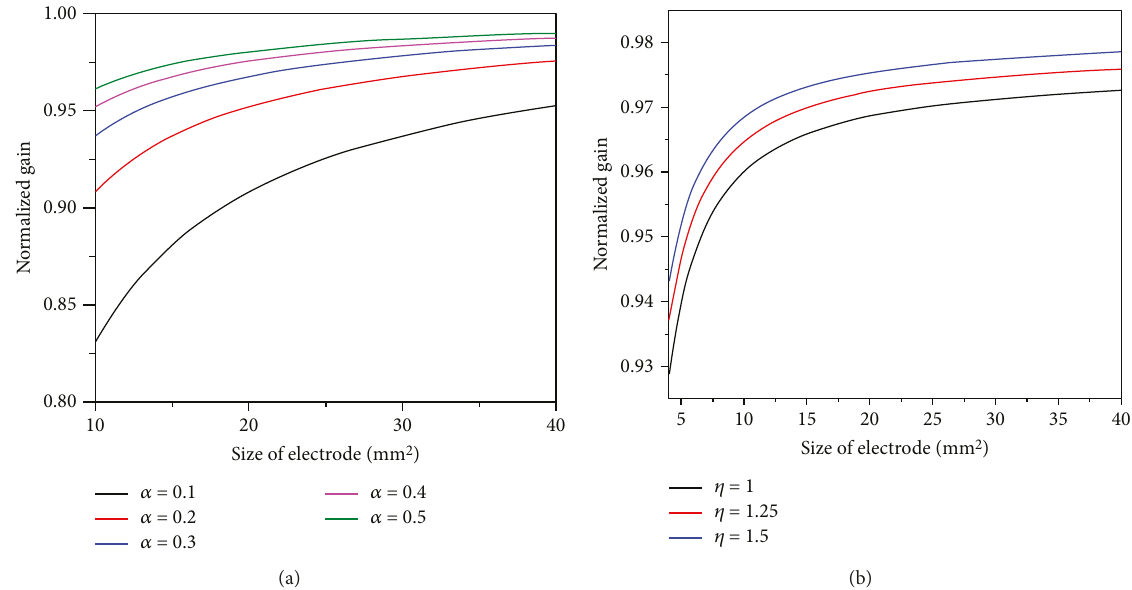
Figure 4: Output signal gain verse with electrode area with (a) di ff erent areal coverage and (b) di ff erent height-width ratio.